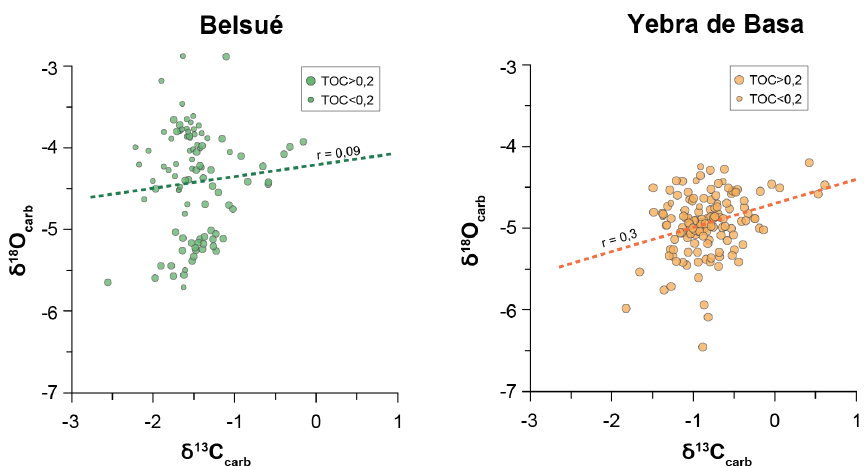
Figure 10. δ 18 O carb – δ 13 C carb scatterplot of all Belsué and Yebra de Basa samples. The size of the symbols is small for samples with TOC < 0.2wt% and big for samples with TOC > 0.2wt%. The Pearson correlation coefficients ( r ) and regression lines are